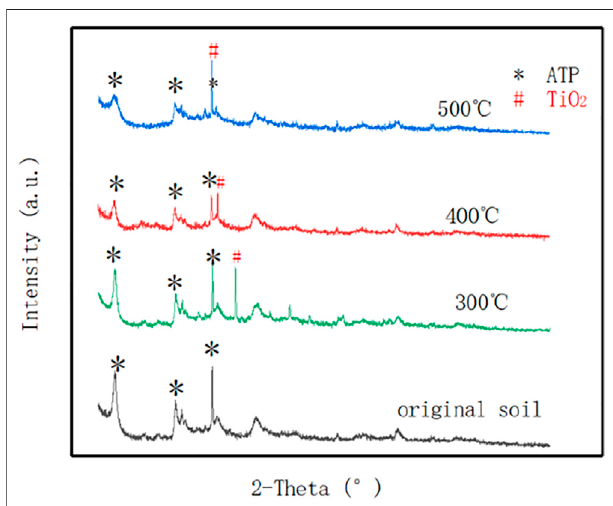
FIGURE3| XRDpatternsofATPandATP/TiO 2 preparedunderdifferent calcination temperture.